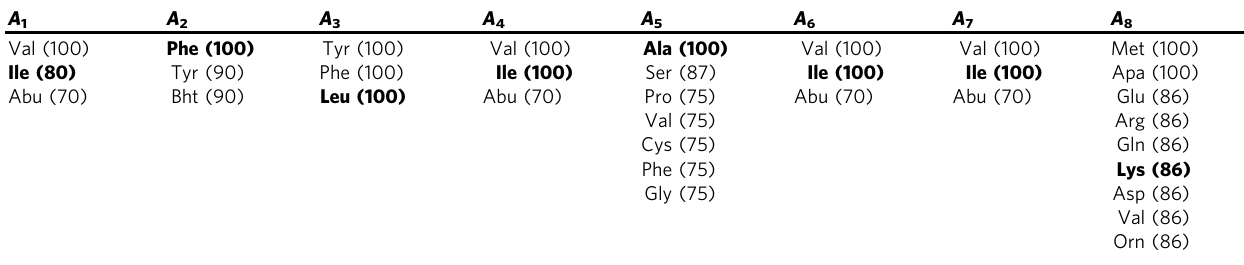
A i represents the set of amino acids predicted for the i th A-domain in SurugamideAL. For each A i at least three amino acids with the highest normalized speci fi city scores (listed in parentheses) are presented. Amino acids appearing in surugamide A (IFLIAIIK) are shown in bold. NRPminer considers all amino acids with the same normalized speci fi city score, as illustrated in the case of the fi fth and the eighth